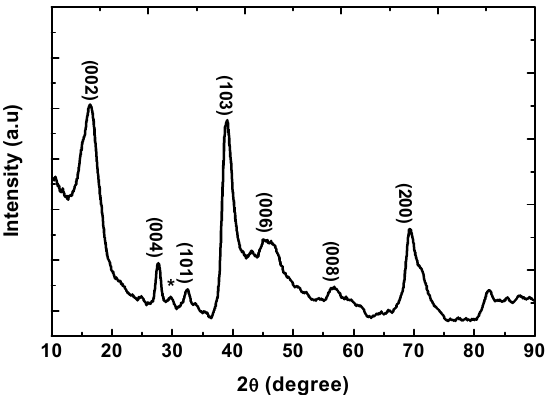
Figure 2. X-ray diffraction pattern of WS 2 nanoflowers. The peak at 29.5° (denoted by *) was assigned to WO 3 .